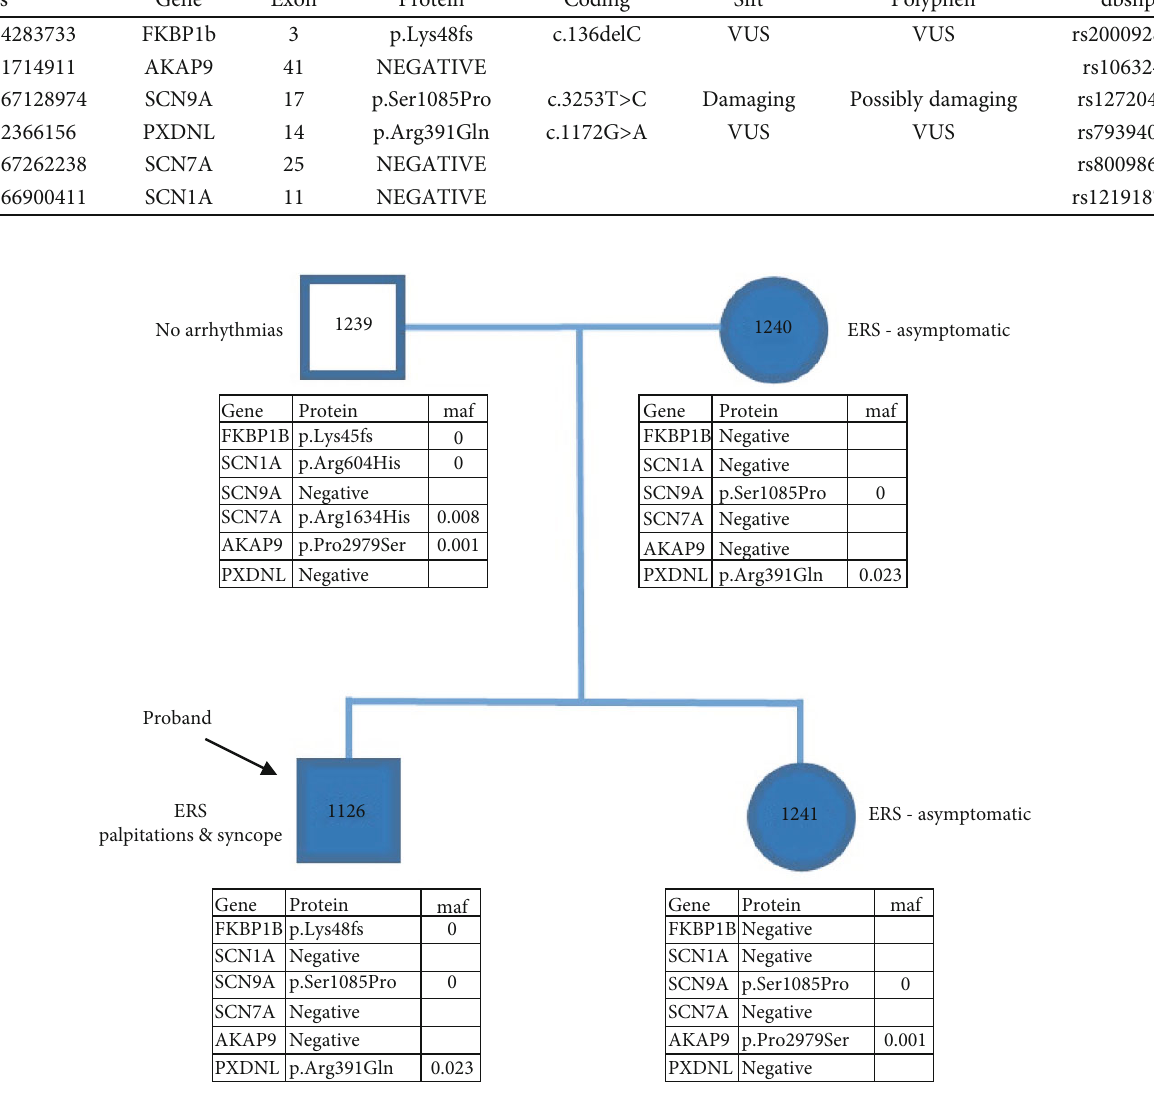
Figure 3: Pedigree of the proband (denoted with arrow) and family. Genetic analysis revealed that each parent carried di ff erent heterozygous mutation(s). The father (1239) carried the FKBP1b mutation, whereas the mother (1240) carried the PXDNL and SCN9A mutations. The sister of the proband (1241) only inherited the mutation in SCN9A. Both parents and the sister were